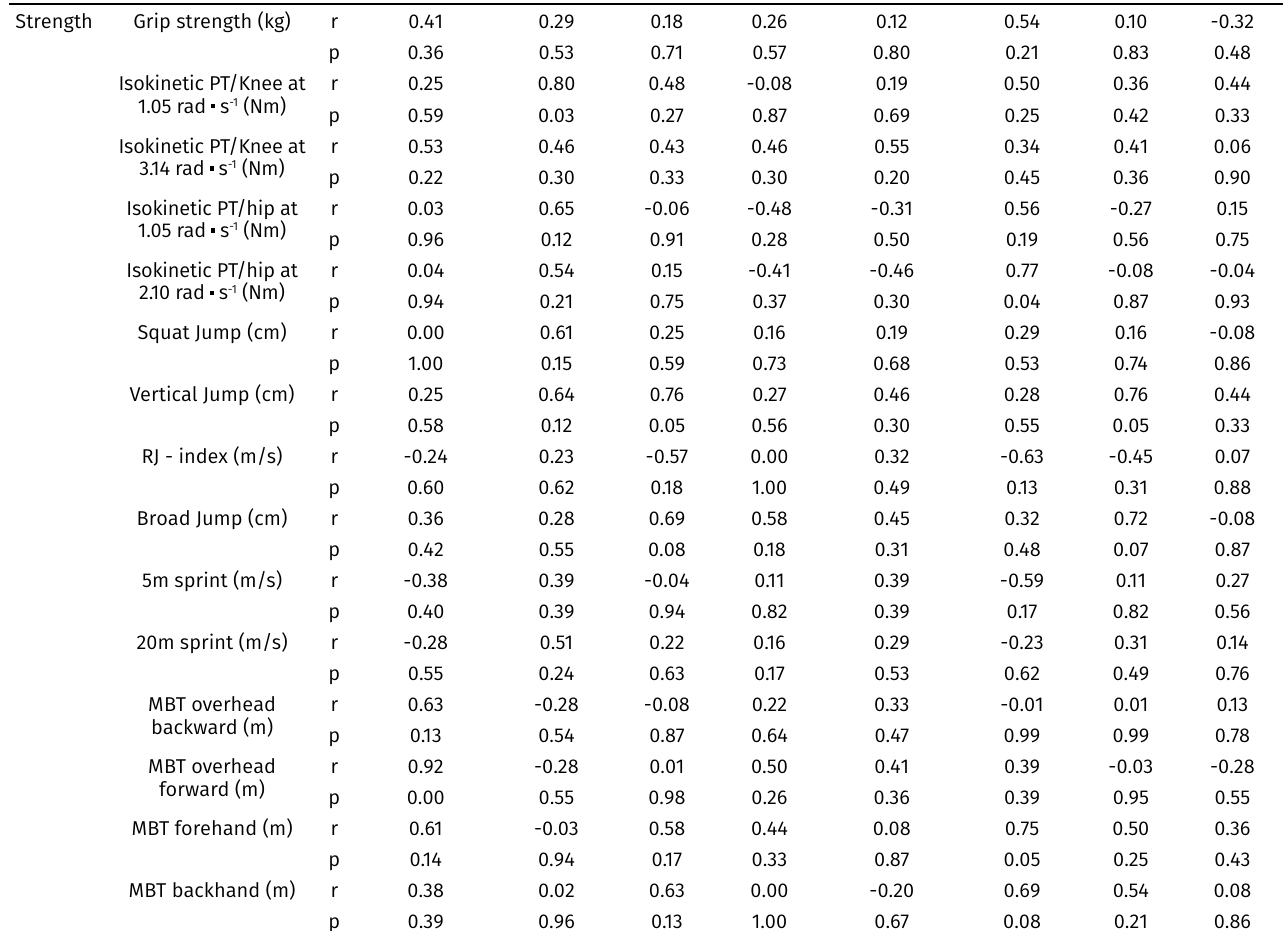
Table 2-2. The partial correlation coefficient of physique and physical strength versus service performance in female players (Continuation). Strength Grip strength (kg)